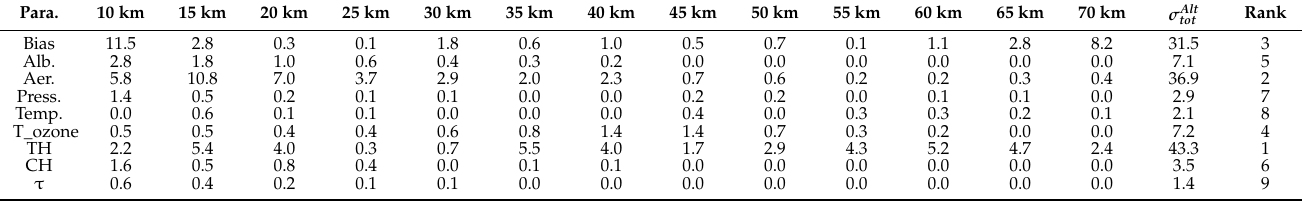
Table 1. Absolute values of the error (%) for retrieved ozone according to each error source. Parameter uncertainties were +0.1 for albedo, − 200 m for TH, AS cloud for cloud height, 200% for cloud optical thickness ( τ ), no aerosols for atmosphere, 15 ◦ N vs. 35 ◦ N profile for bias, in addition to pressure and temperature, as well as a comparison between 223 and 243 K ozone cross-section